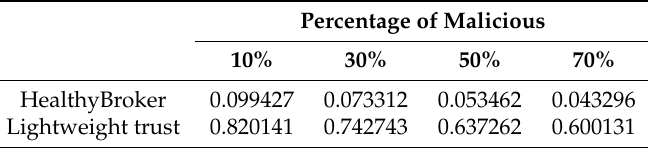
Table 3. MAD results with feedback malicious collective.